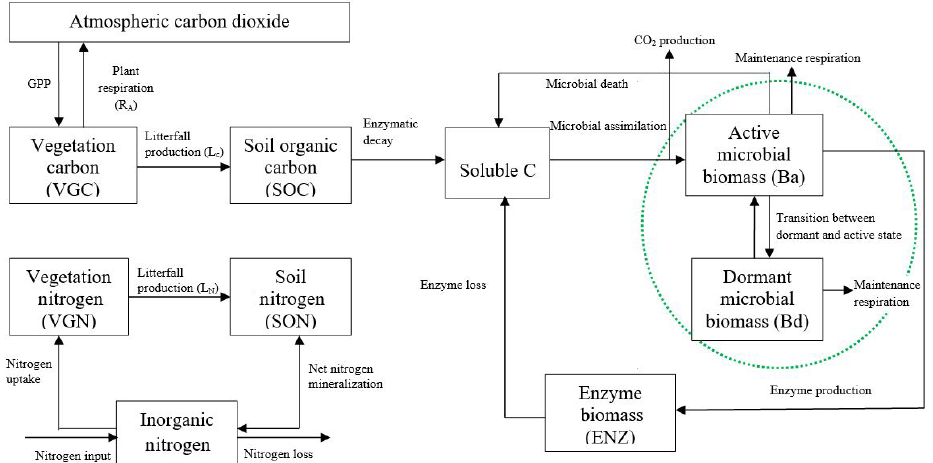
Figure 1. Framework of the dormancy model: microbial biomass is split into two parts, active microbial biomass and dormant microbial biomass (shown in the green dashed circle). Maintenance respiration from these two parts and the CO 2 production through microbial assim- ilation contribute to heterotrophic respiration. The model was revised based on Zha and Zhuang